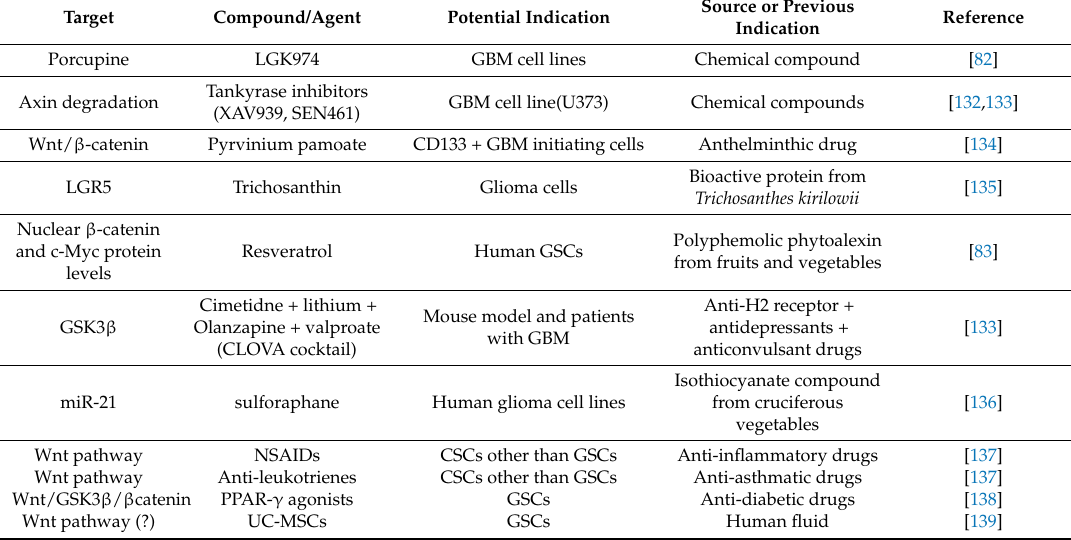
Table 1. List of some old and new drugs able to target Wnt pathway that have been shown to be beneficial in experimental glioblastoma multiforme (GBM) therapeutic management, thus representing potential candidates for clinical